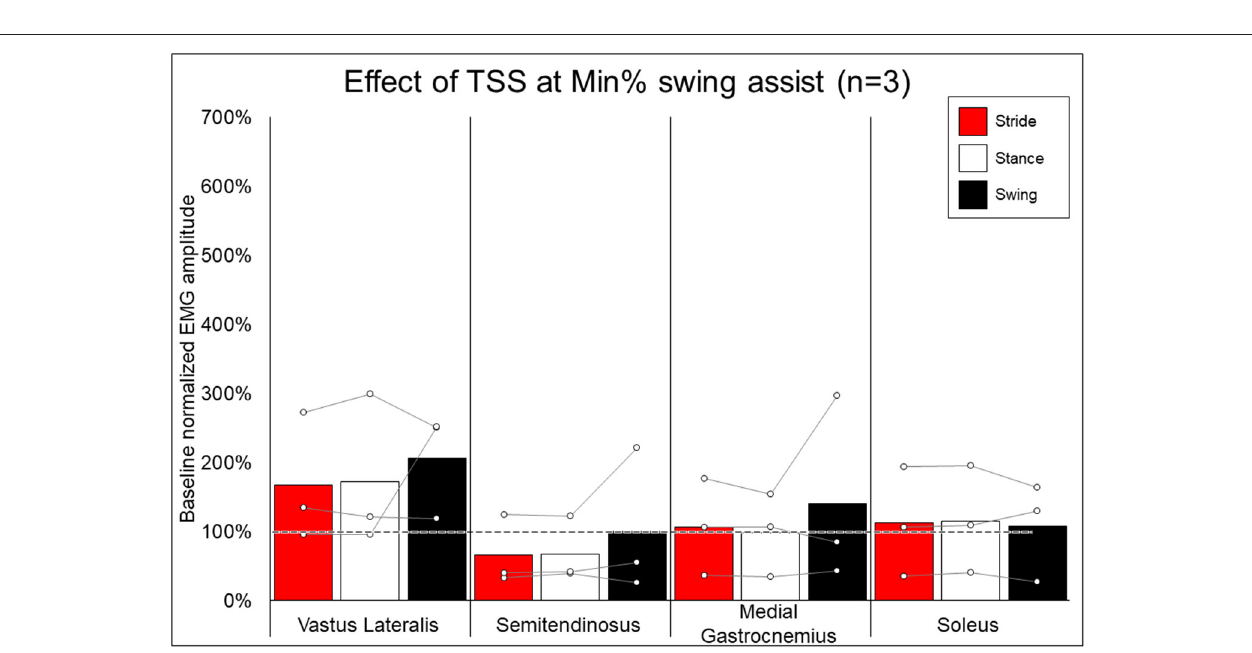
FIGURE 8 | Effect of adding trans-spinal stimulation to exoskeletal assisted walking at minimum percent assistance achieved through training. Bars representing group averages and dots representing individual participants show EMG amplitudes during Min% normalized as a percent of average EMG amplitudes when walking at 100% assistance (represented by the dotted line on the